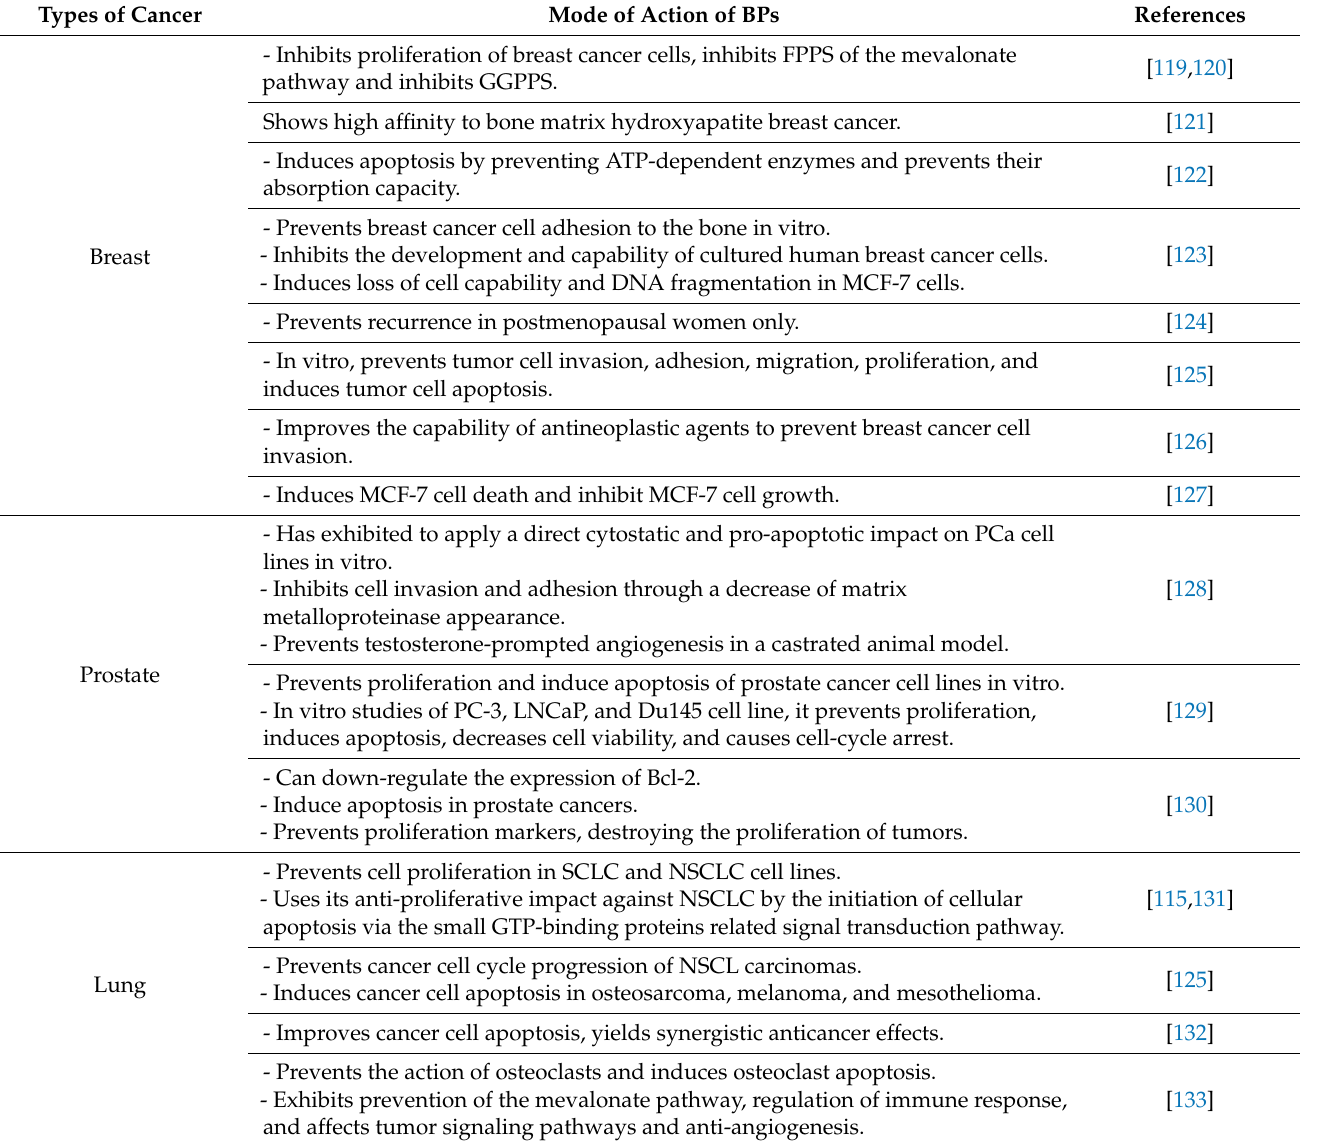
Table 6. Mode of action of BPs in breast, prostate, and lung